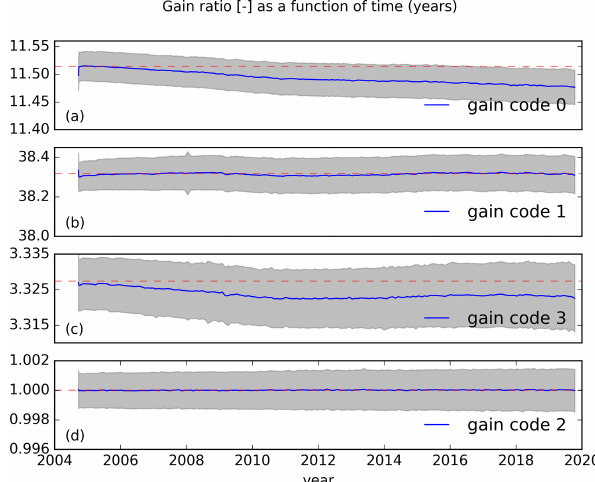
Figure 1. The trend over 15 years for the four gain ratios of the UV detector. Results are similar for the VIS channel and are not shown here. The panels show the calibrated gain ratio in each month as a blue line together with the 1 σ standard deviation indicated by the gray-shaded area. The dashed red line shows the gain ratio values at the start of the